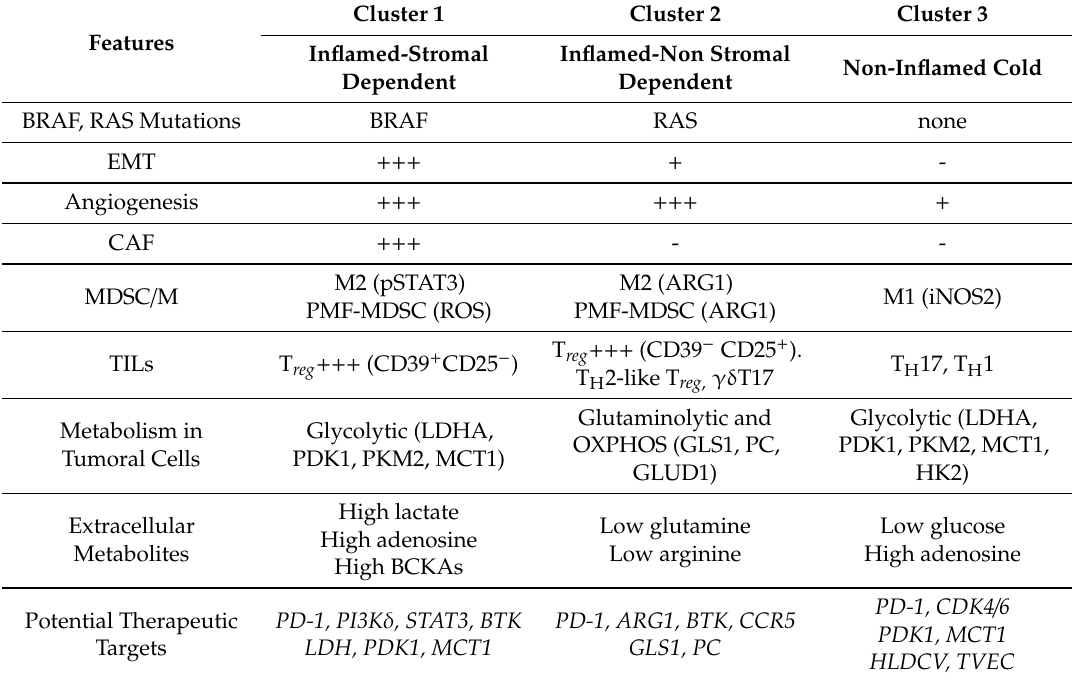
Table 1. Biologically and clinically relevant features in metastatic colorectal cancer (mCRC) as inferred for GAstrointestinal Immune-Signature (GAIS)42 immune-metabolic (IM)